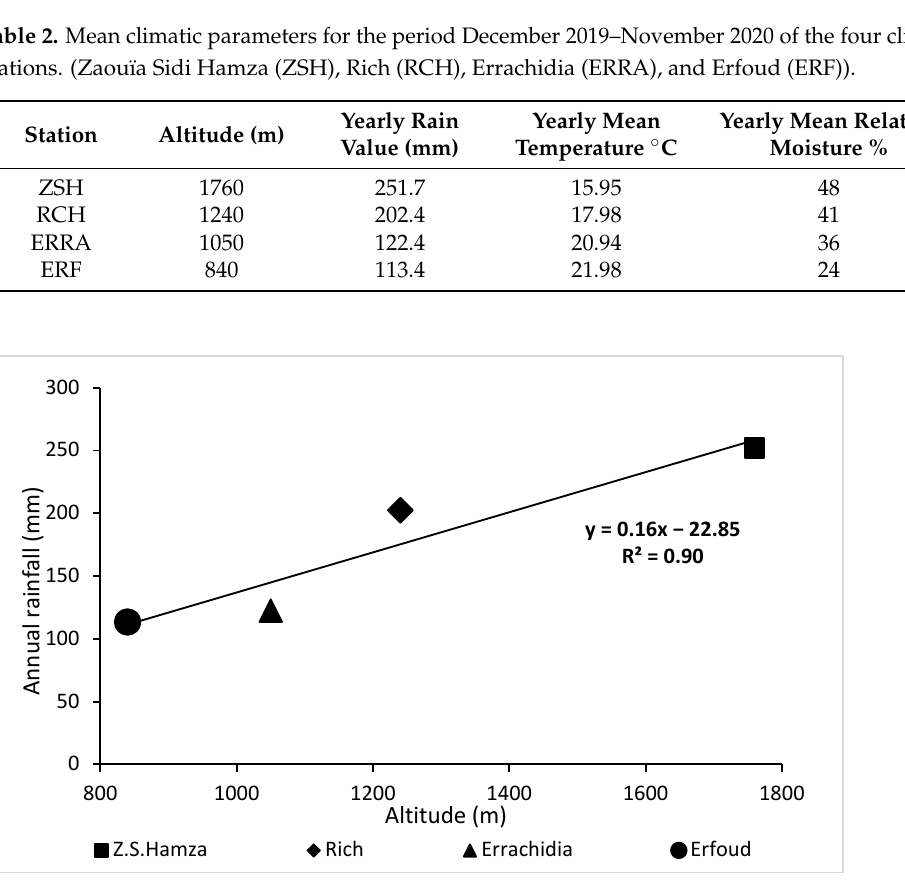
Figure 7. Number of rainy days at the four sampling stations (period December 2019–November 2020).